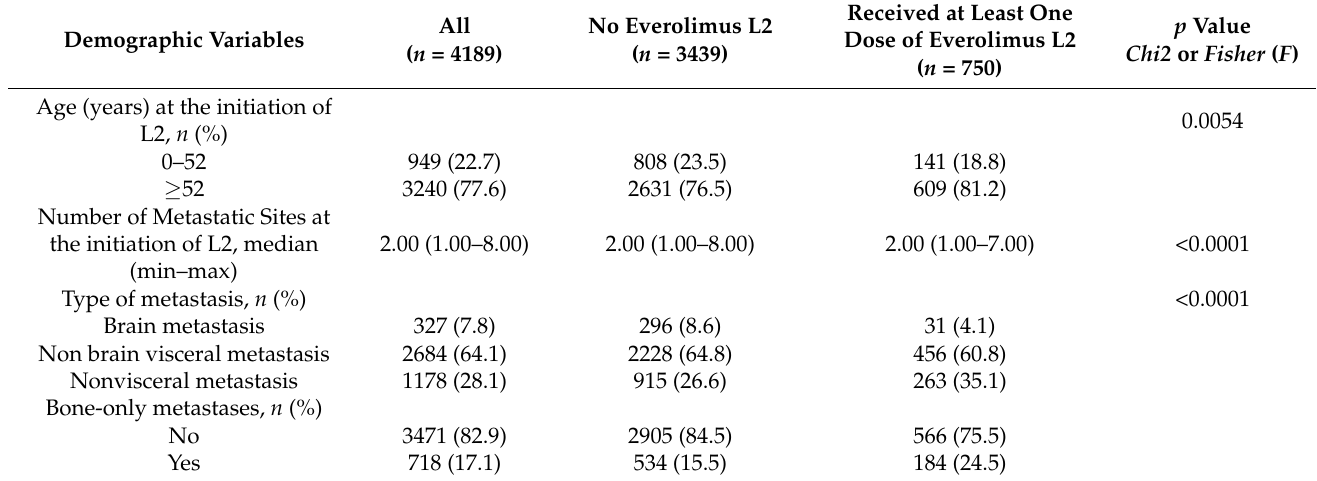
Table 3. Patient characteristics at the initiation of line 2.